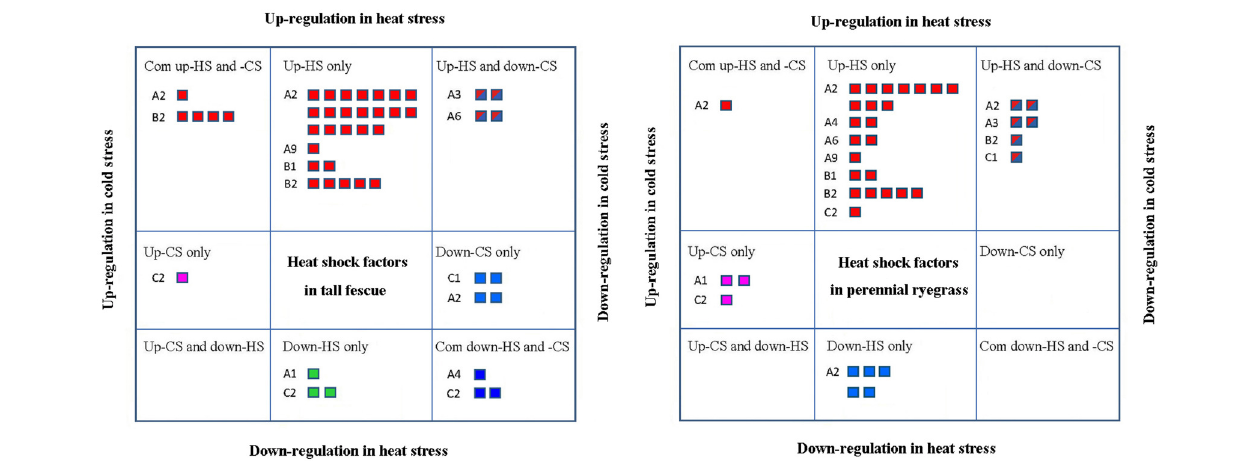
FIGURE 5 | Stress-response analyses of different Hsf classes showing significant expression differences at least one stress condition. “Up-HS only” indicates upregulated heat shock factors ( Hsfs ) only under heat stress (HS); “Down-HS only” represents downregulated Hsfs only under HS; “Up-CS only” represents upregulated Hsfs only under cold stress (CS); and “Down-CS only” denotes downregulated Hsfs only under CS. “Com up-HS and CS” indicates upregulated Hsfs under HS and CS, and “Com down-HS and CS” represents downregulated Hsfs under HS and CS. “Up-HS and Down-CS” shows Hsfs upregulated under HS and downregulated under CS, and “Up-CS and Down-HS” denotes Hsfs downregualted under HS and upregulated under CS.